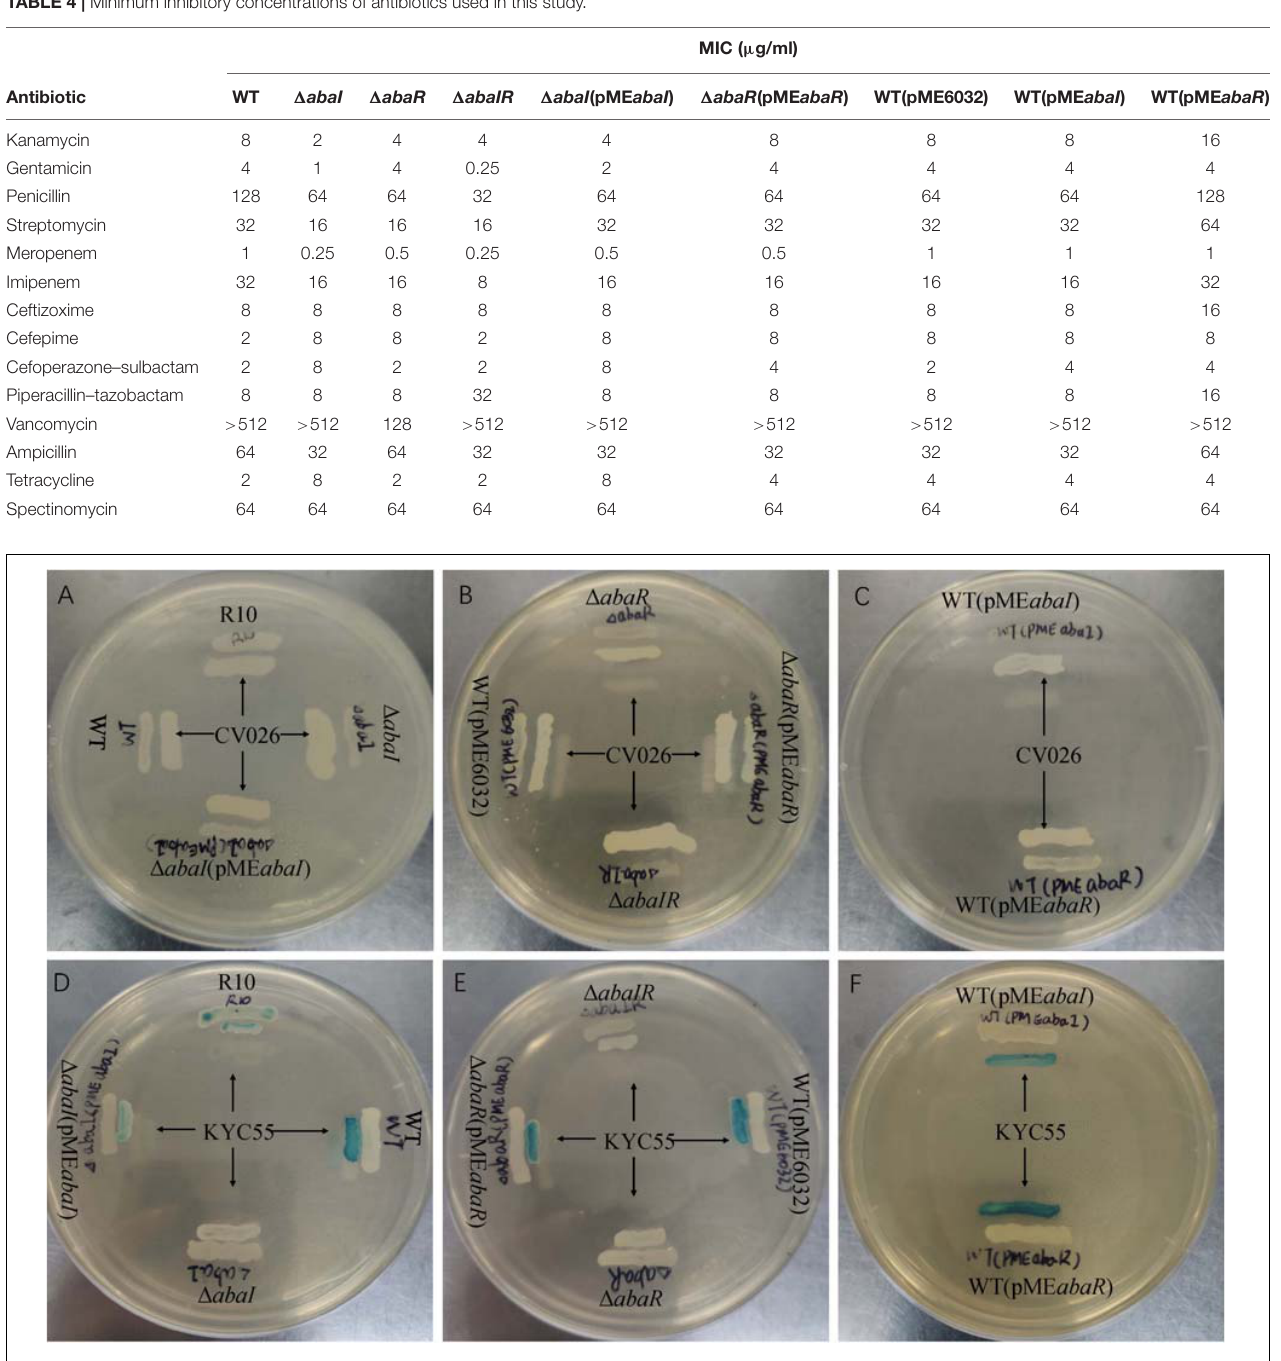
FIGURE 2 | Screening of WT and mutants for AHL production using agar plate well diffusion assay with C. violaceum CV026 and A. tumefaciens KYC55 reporter strains. (A–C) WT, mutants and AHL positive strain R10 were tested with CV026. (D–F) WT, mutants and AHL positive strain R10 were tested with KYC55.